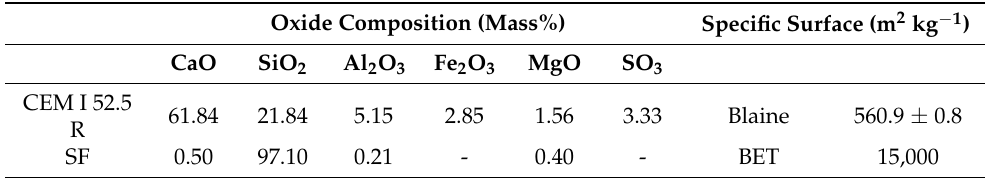
Table 2. Oxide composition and specific surface of the used Portland cement and SF. Depicted values of a specific surface area represent the average of three measurements.